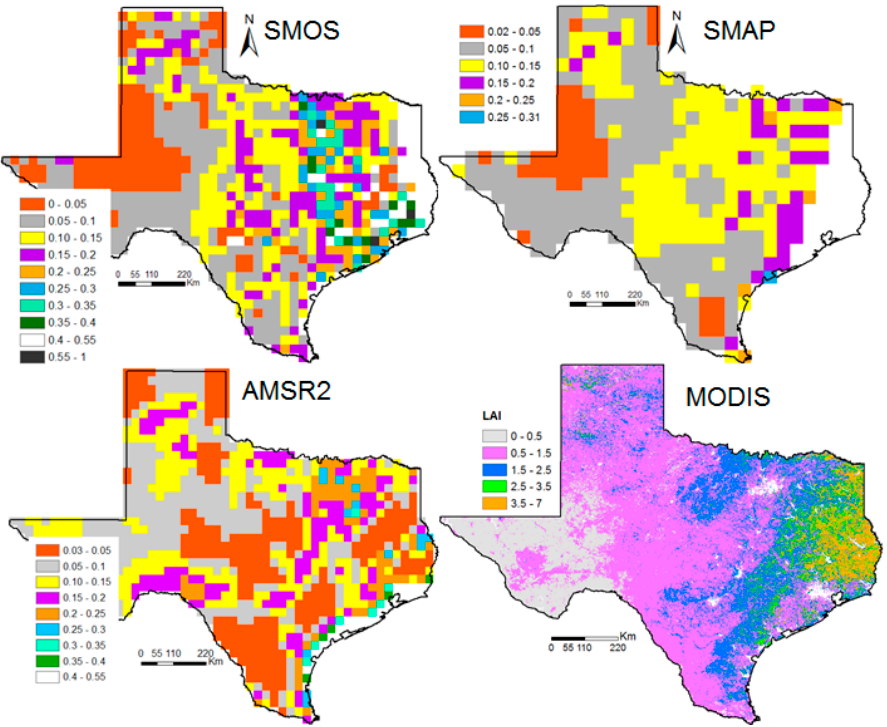
Figure 6. Soil moisture distributions for selected dry day (19 July 2015) across the state of Texas in the 2015 wet year.